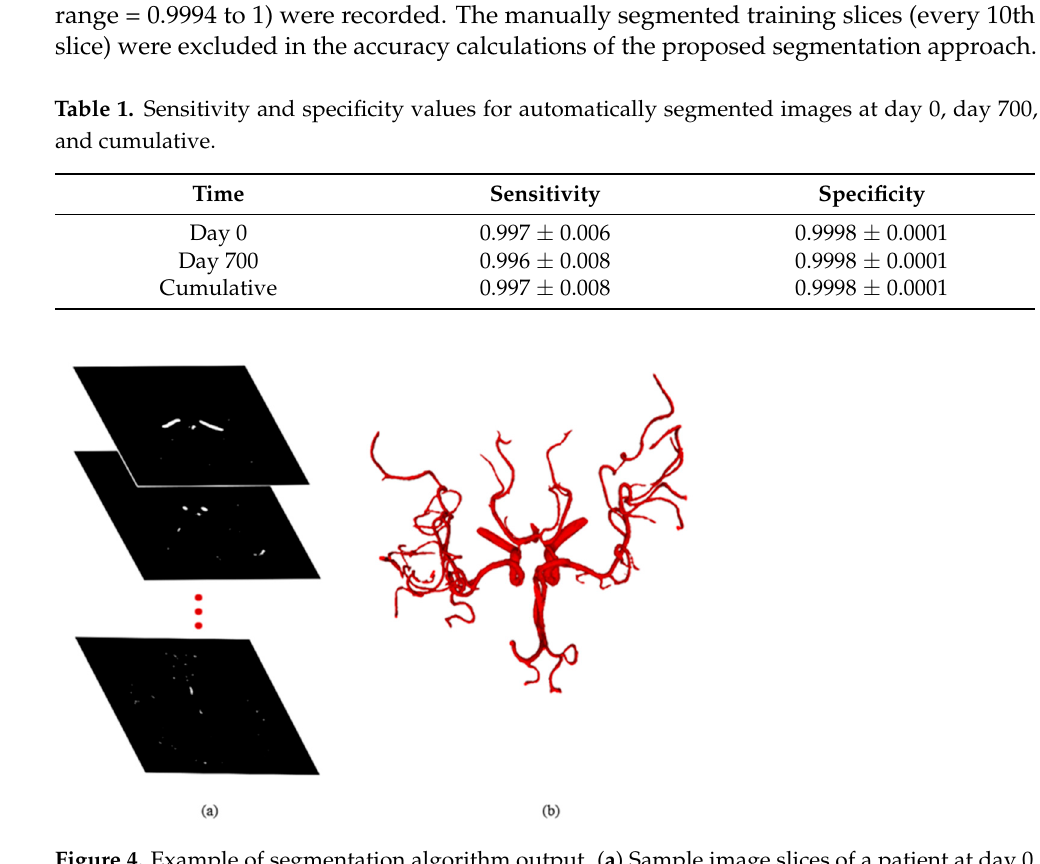
Table 2. Statistical evaluation mixed effects linear model, where p -values < 0.05 were considered statistically significant. Diameter denotes size of vasculature in segmentation images. Age, gender, and timepoints are clinically acquired data. Mean Vascular Diameter below Circle of Willis Effect